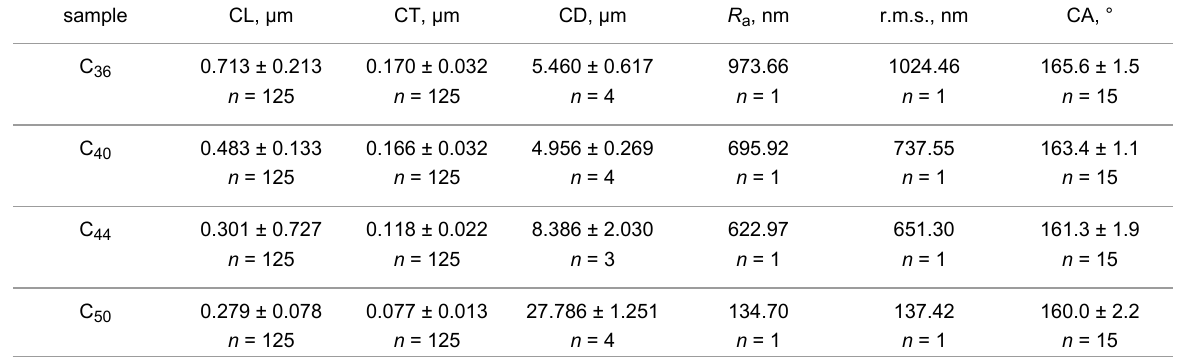
Table 1: Morphometrical variables of crystals, surface roughness, and wetting properties of wax samples.